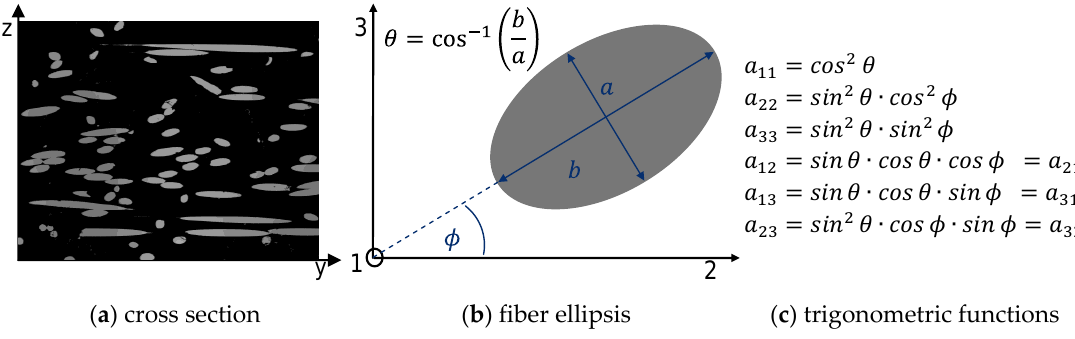
Figure 8. Cross section analysis to experimentally determine fiber orientation